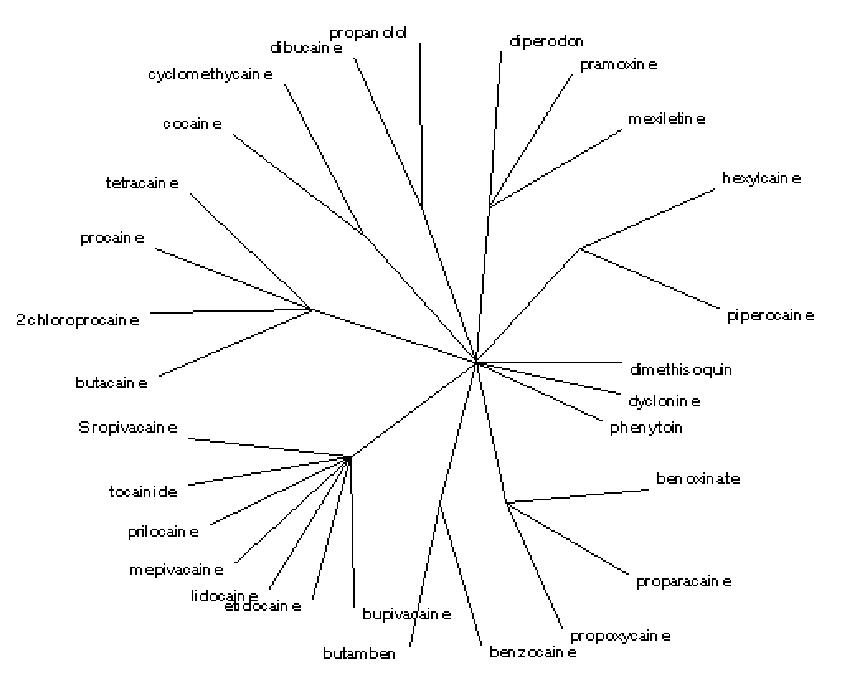
Figure 3. Radial tree for the local anaesthetics analogues of proacine at level b